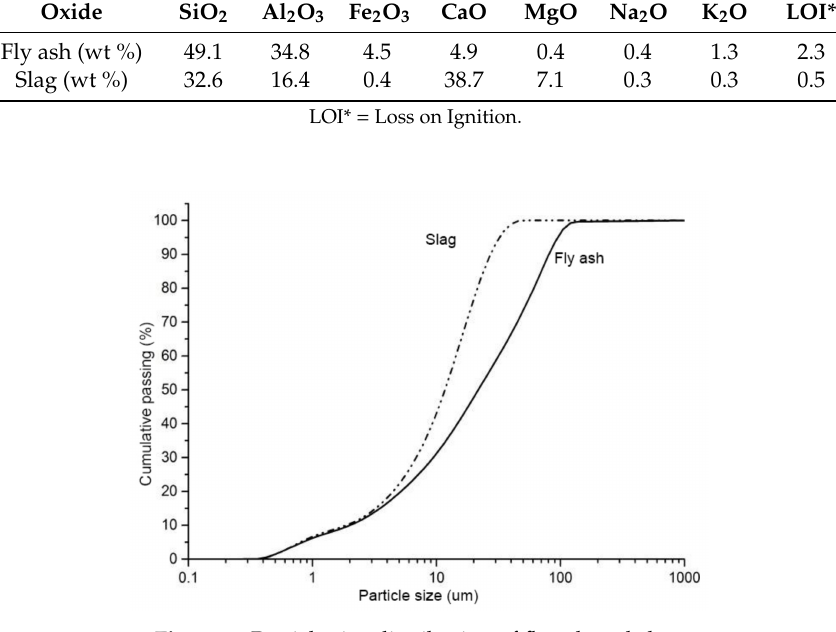
Figure 1. Particle size distribution of fly ash and slag.